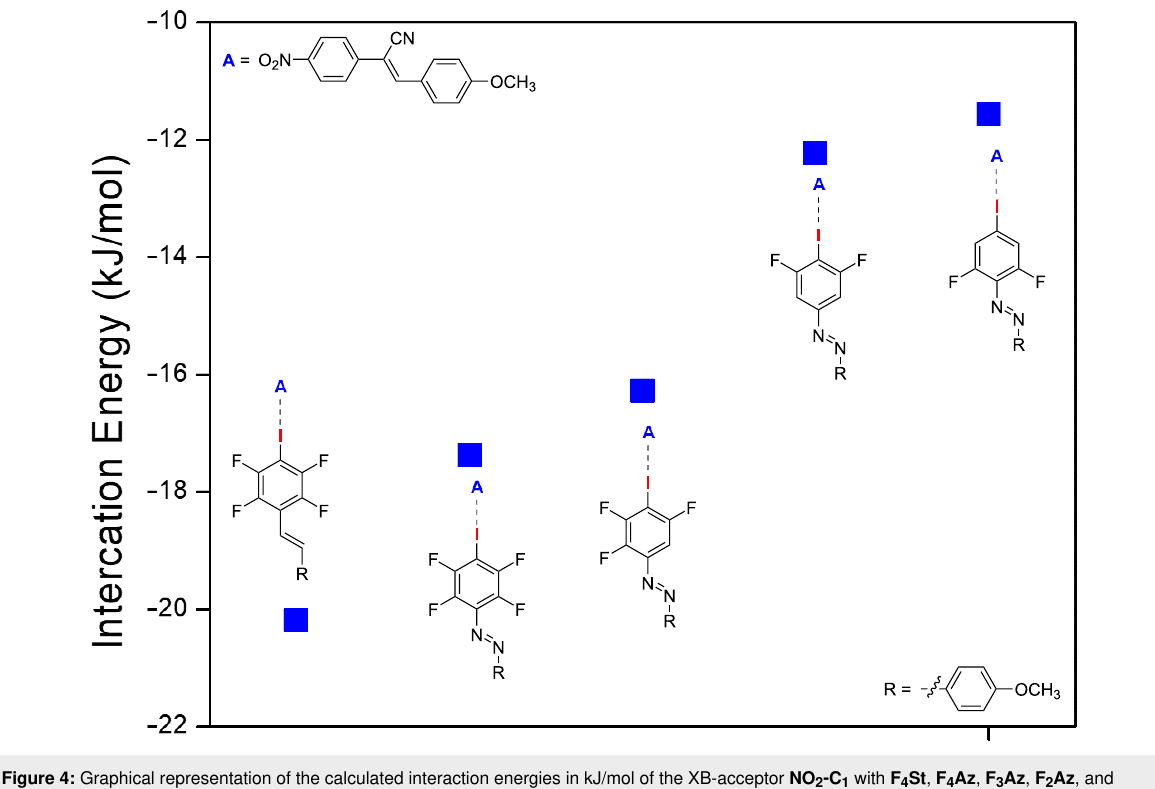
Figure 4: Graphical representation of the calculated interaction energies in kJ/mol of the XB-acceptor NO 2 -C 1 with F 4 St , F 4 Az , F 3 Az , F 2 Az , and F 2 ’Az . For computational efficiency, the octyl chains have been replaced by methoxy groups.